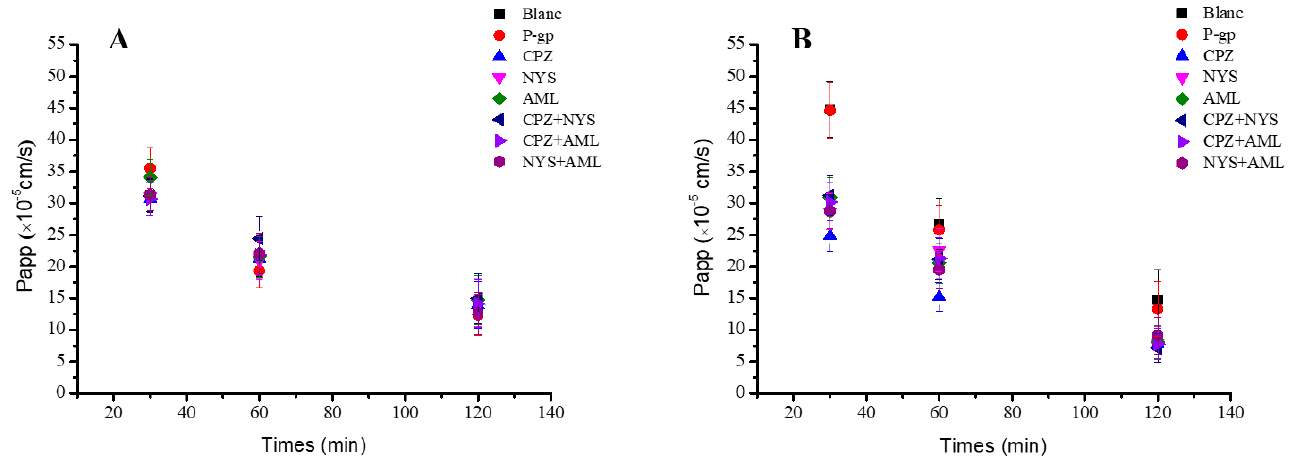
Figure 6. Verapamil, Chlorpromazine, Nystatin, Amiloride, and two of the three affected during transport of PHP 0.5MSC-F and PHP H-1-2 in the AP → BL direction at different times of 30 min, 60 min, and 120 min: ( A ) PHP 0.5MSC-F (200 μ g/mL); ( B ) PHP H-1-2 (200 μ g/mL).